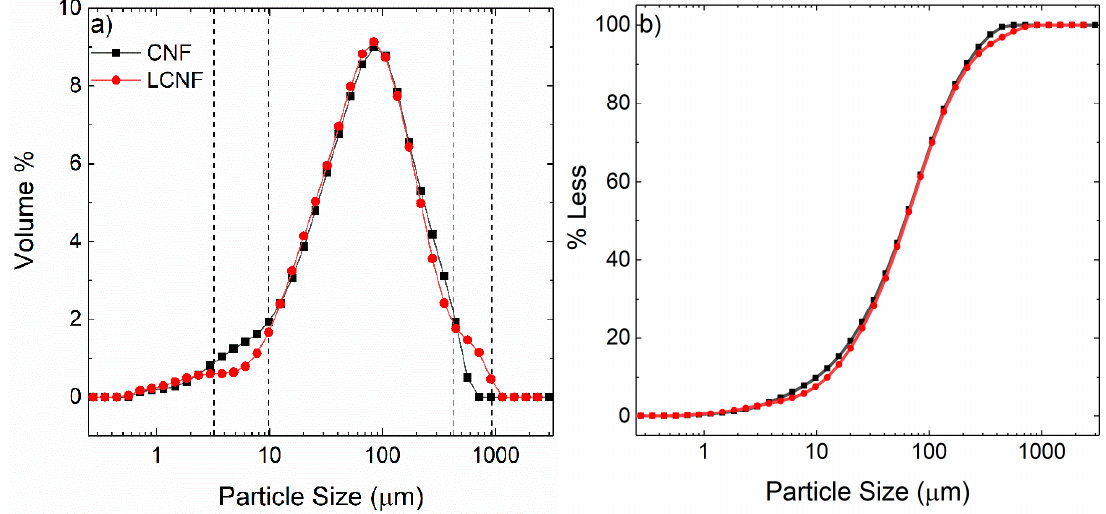
Figure 3. ( a ) Comparison in particle size distribution between CNF and LCNF. ( b ) The corresponding cumulative volume distribution.